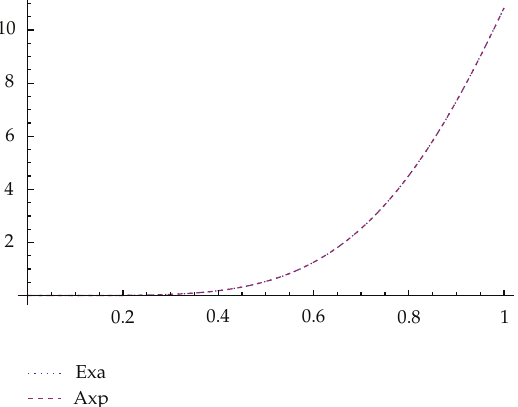
Figure 3: Comparison of the approximate solution u n (cid:6) x (cid:7) and u (cid:6) x (cid:7) at n (cid:9) 128 for Example 4.3.